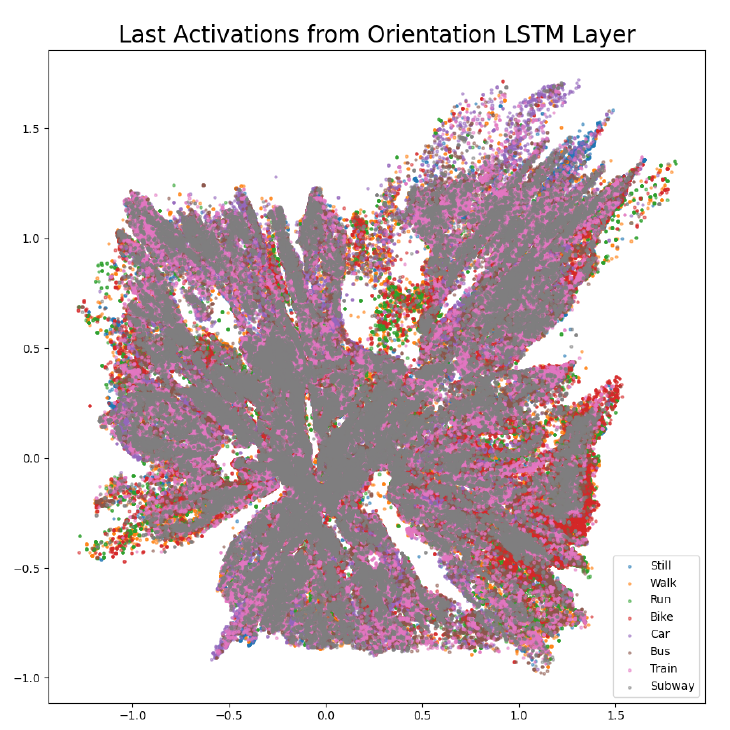
Figure 14. The 2D encoded representation of the last activations of the LSTM layer for the orientation software sensor. Color codes: blue (still), orange (walk), green (run), red (bike), violet (car), brown, (bus), pink (train), grey